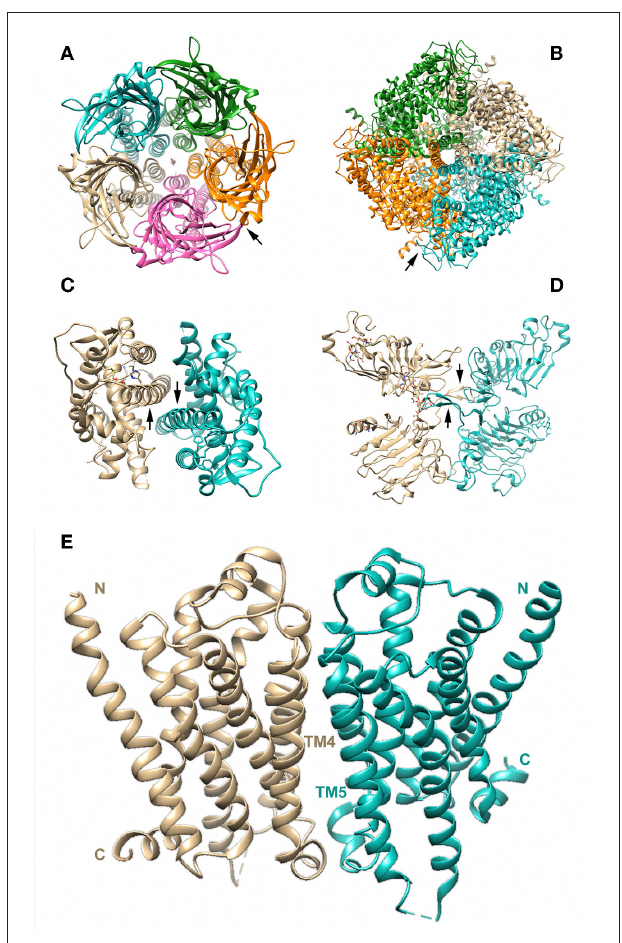
FIGURE 1 | Multimeric molecular structures of receptors from different families, as determined by crystallographic studies. The protomers forming each complex are shown in different colors. (A) Top view (from the extracellular side) of a pentameric LGCI, namely a cationic ligand-gated ion channel [PDB code: 5HCJ; (112)]. The arrow indicates the interface between subunits, where the orthosteric binding site is located, halfway between the membrane and the top of the extracellular domain. (B) Bottom view of a tetrameric VGIC, the human transient receptor potential ion channel M 4 [PDB code: 6BQV; (113)]. The arrow indicates the interface between neighboring monomers. The cytoplasmic domain involves four homology regions (MHR1 to MHR4) and MHR1 of one subunit interacts with MHR3 of the adjacent subunit to form the interface. (C) Dimeric HNR, the human estrogen receptor 1 [PDB code: 1X7E; (114)]. In each monomer, the arrow indicates helix 10/11, where the dimer interface is formed; (D) Dimeric extracellular domain of a human RTK, the EGFR [PDB code: 5WB7; (115)]. Arrows indicate the dimerization arms mediating dimer formation. (E) GPCR homodimer of β 1 -adrenergic receptors [PDB code: 4GPO; (116)]. N and C terminals are indicated. The dimerization interface has been shown to involve TM4 and TM5 (117). As illustrated, oligomerization plays an important role in the function of all receptor families, including GPCRs. Although GPCRs mostly signal as monomers, there